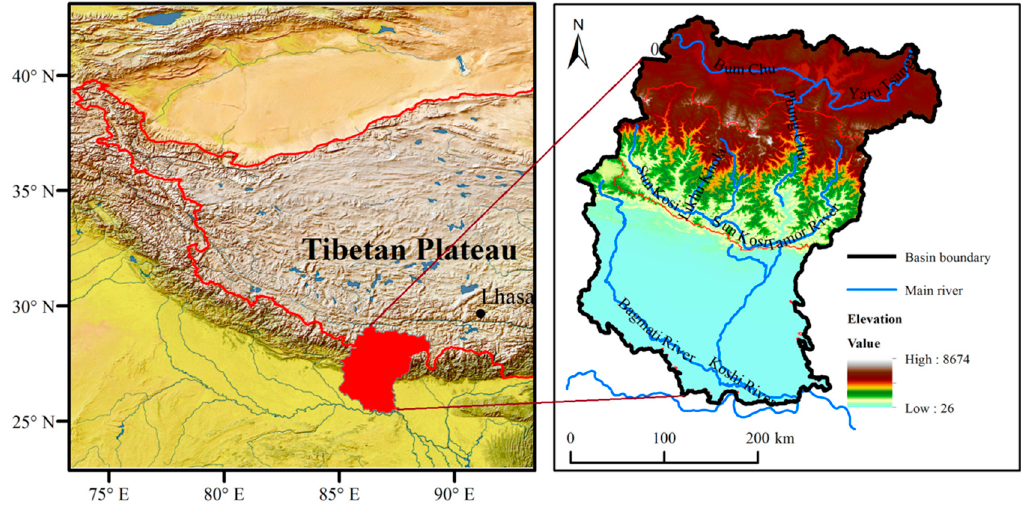
Figure 1. Location of the Koshi River Basin (KRB), its elevation ranges and main rivers.